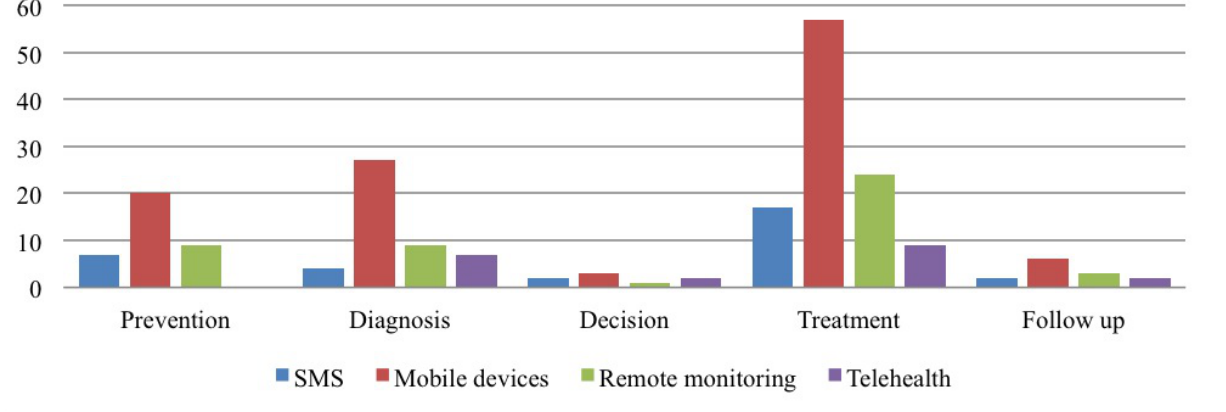
Figure 8. Mobile technologies in health care process